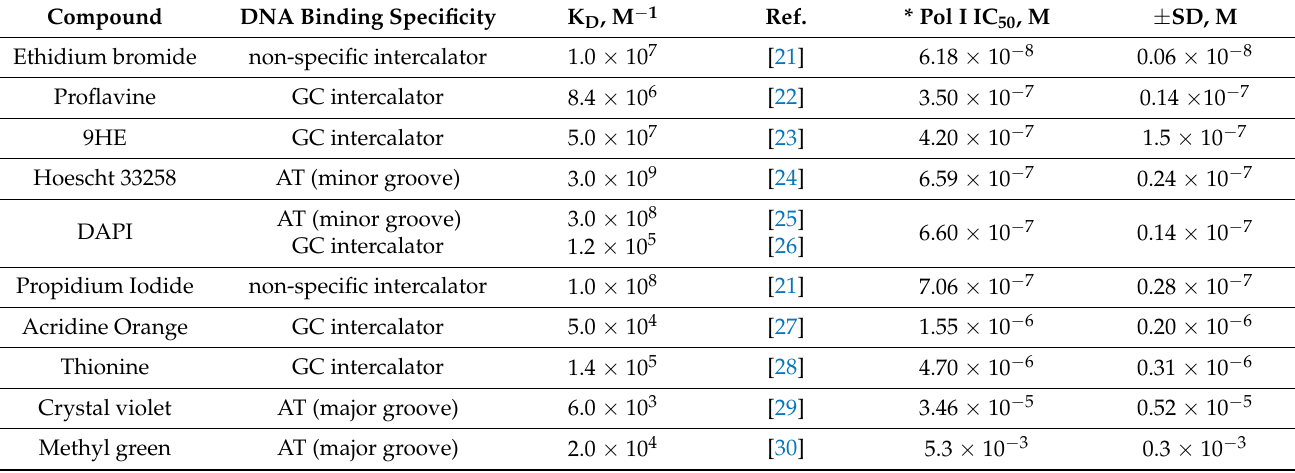
Table 1. In vitro IC 50 concentrations for a range of DNA intercalators/groove binders.